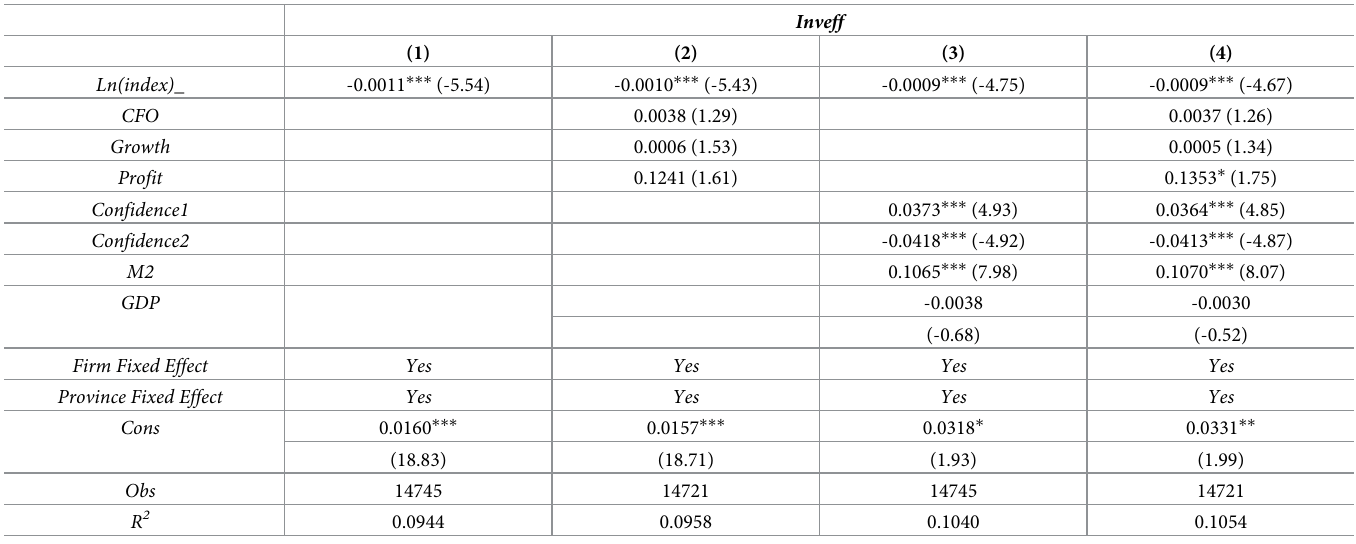
Table 9. Robustness check: Replacing dependent